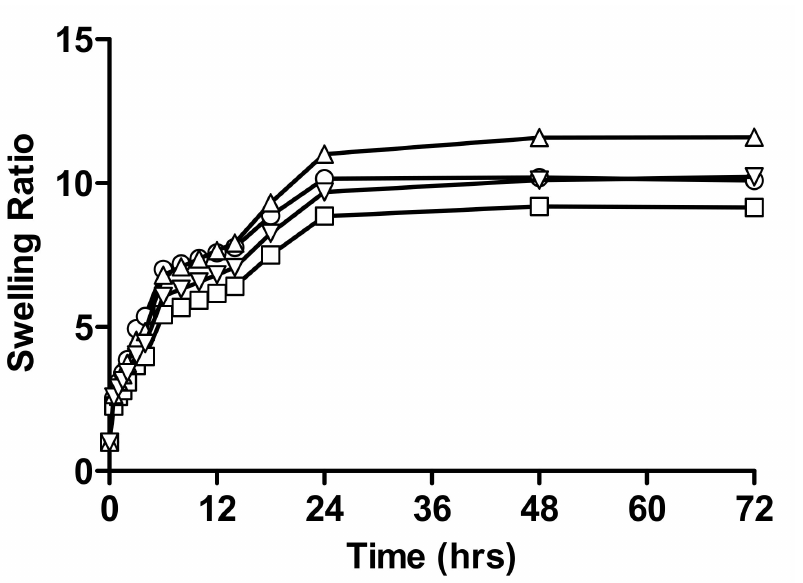
Figure 4. Relative swelling ratios of linseed-co-AAM graft copolymer hydrogels with varying crosslinker concentration; ( ) F6 at pH 1.2, ( (cid:3) ) F7 at pH 1.2, ( (cid:52) ) F6 at pH 4.5 and ( (cid:53) ) F7 at pH 4.5. (cid:35)